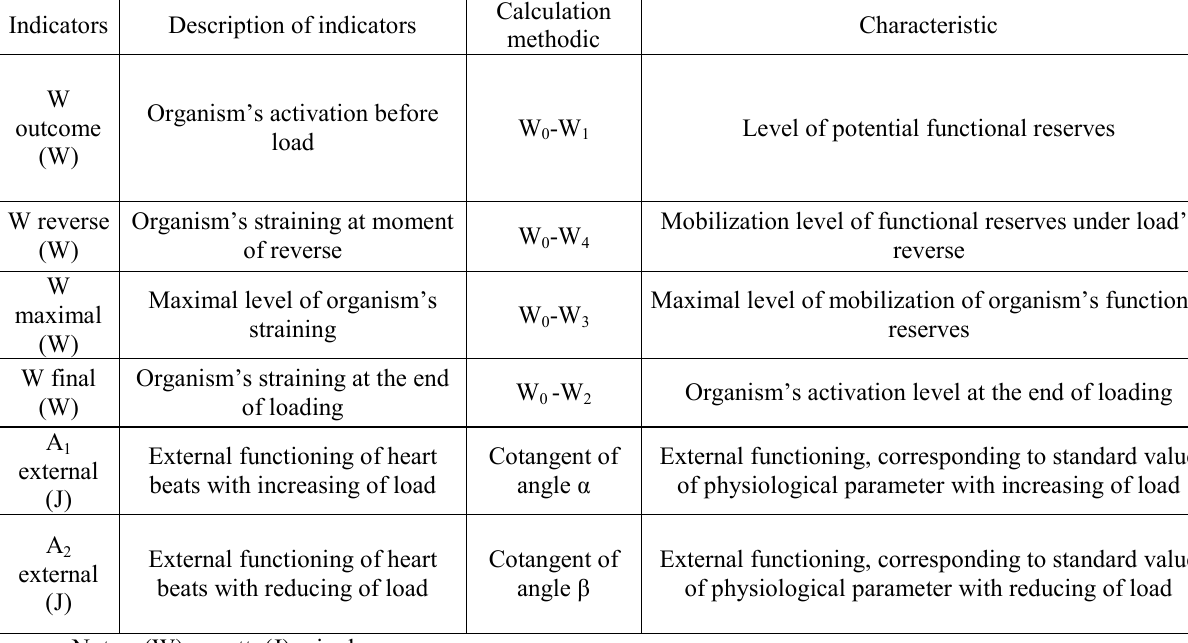
Indicators of energetic level of